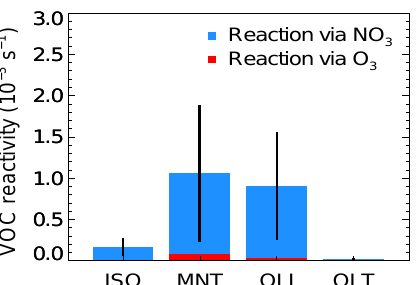
Figure 8. The nighttime VOC reactivity of NO 3 and O 3 (defined as the first-order loss rate of VOCs initialized by oxidants, including NO 3 and O 3 ); the VOCs are classified as isoprene (ISO), monoter- pene (MNT), terminal alkenes (OLT), and internal alkenes (OLI). The data were selected from 20:00 to the next day at 04:00CNST.